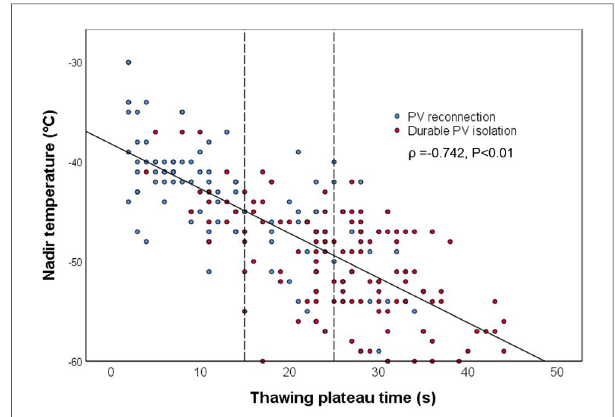
solid line shows the trend of correlation, while the dotted lines demonstrate cut points for PV reconnection (15 s) and for durable PV isolation (25 s), respectively. PV, pulmonary vein.